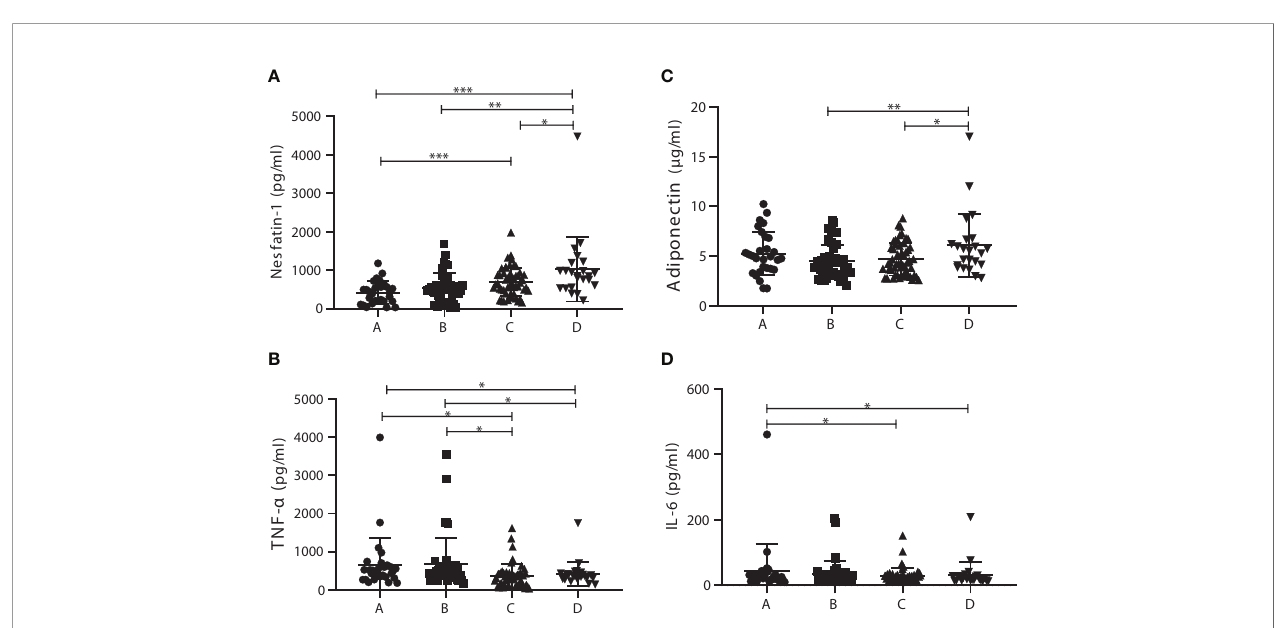
FIGURE 2 | Comparison of serum levels of nesfatin-1, tumor necrosis factor a (TNF- a ), adiponectin, interleukin 6 (IL-6) among the homeostasis model assessment of insulin resistance (HOMA-IR) subgroups. (A) Nesfatin-1 levels in subgroup D were signi fi cantly increased compared with those in the other subgroups; nesfatin-1 levels in C subgroup were also signi fi cantly elevated in comparison to A subgroup. (B) TNF- a levels in subgroups A and B were outstandingly upregulated compared to those in subgroup C or D. (C) Adiponectin in subgroup D was signi fi cantly higher than that in subgroup B or C but no difference between A and D subgroup. (D) IL-6 levels in A subgroup were obviously elevated in comparison to that in C or D subgroup except B subgroup. A: subgroup of T2DM patients with HOMA-IR <2.8, B: subgroup of T2DM patients with HOMA-IR >2.8, C: subgroup of prediabetics with HOMA-IR <2.8, D: subgroup of prediabetics with HOMA-IR >2.8. * P < 0.05, ** P < 0.01, *** P <